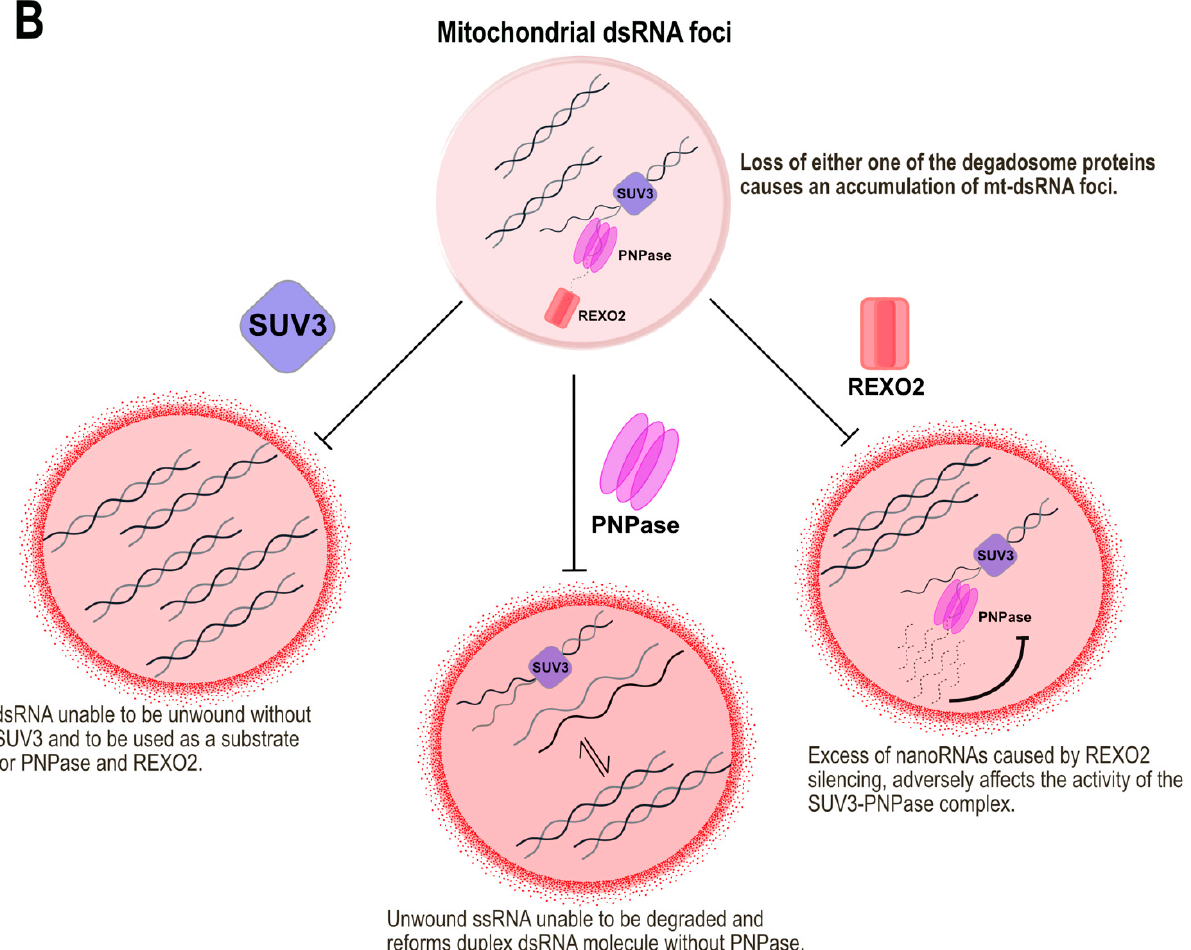
Figure 2. Consequences on the structure of MRGs and mt-dsRNA foci when its components are dysregulated. ( A ) Various bona fide MRG proteins phase out into liquid droplets, surrounding an RNA core in MRGs. The silencing of any one of these proteins does not destroy the persistence of MRGs in the matrix. The loss of the crucial nascent RNA core leads to the dissolution of MRGs. However, in this case, the MRG proteins can still be found diffused throughout the matrix when visualized by immunofluorescence. Enlarged mitobulbs of mitochondria are the result of disrupted membrane dynamics. Nucleoids and MRGs form tight clusters within them while maintaining their individual structures. ( B ) The loss of either one of the degradosome proteins of SUV3, PNPase and REXO2 causes an accumulation of mt-dsRNA foci in the matrix. The silencing of each of these proteins results in a different mechanism leading to the accumulation of mt-dsRNA relating to its function.